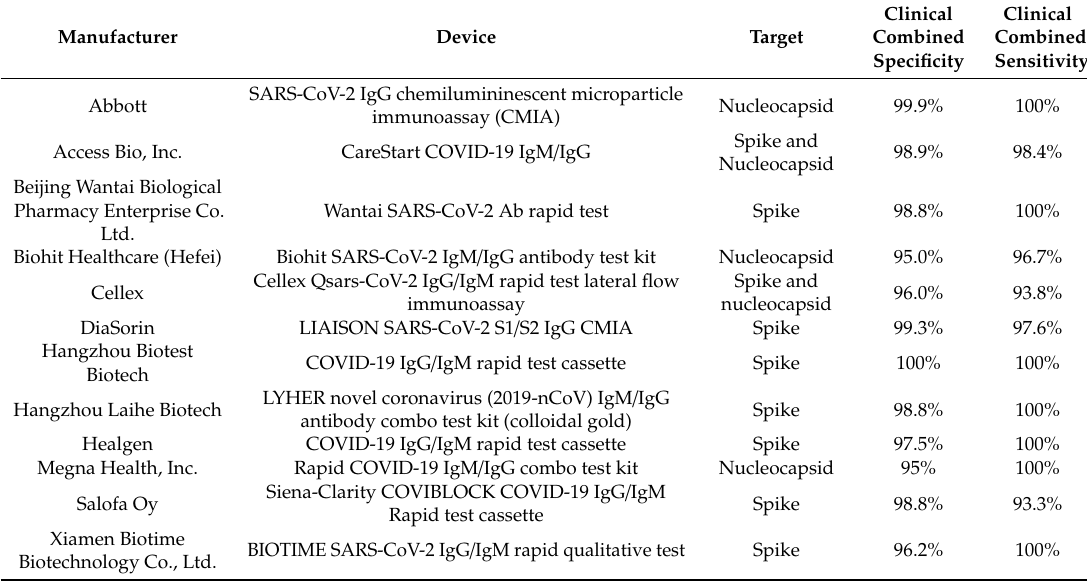
Table 2. FDA commercially authorized biosensors for SARS-CoV-2 detection